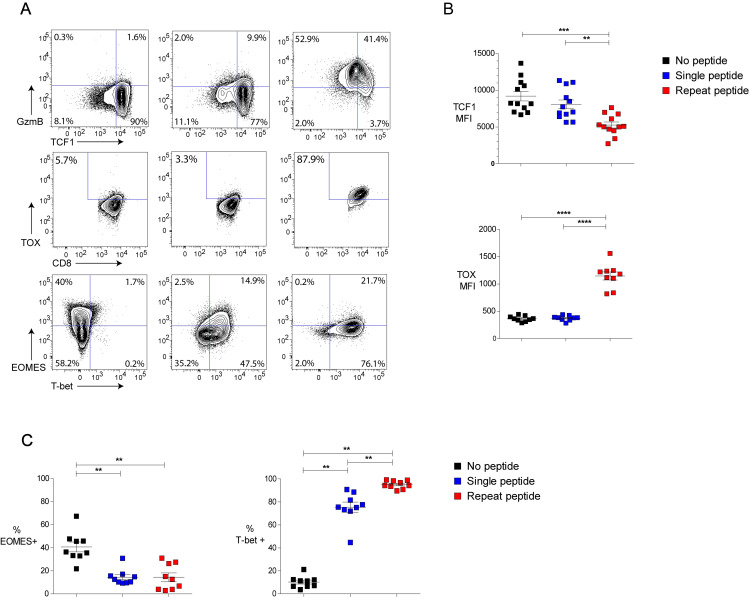
Repeat peptide stimulation induces a distinct pattern of transcription factor expression.Transcription factors (TF) were analyzed in OT-I CD8+ T cells on day 5 of culture. Cells either unstimulated (no peptide), stimulated one time (single peptide) or daily (repeat peptide) shown. (A) Representative flow cytometry plots of the frequency of TF-expressing live CD8+ T cells shown for the differently treated cultures. (B) Pooled data depicting the MFI of TCF1 and TOX in live CD8+ T cells. (C) Pooled data showing the frequency of EOMES and T-bet expressing live CD8+ T cells. Each symbol represents one animal (n = 9–12), with n = 7–9 independent experiments performed. Line depicts mean ± SE. ANOVA with Tukey’s post hoc test was performed on TCF1 MFI, Student’s t test with Welch’s correction was used for TOX MFI and Wilcoxon signed rank test for data in (C). *<0.05, **P<0.01, ***P<0.001, ****P<0.0001.